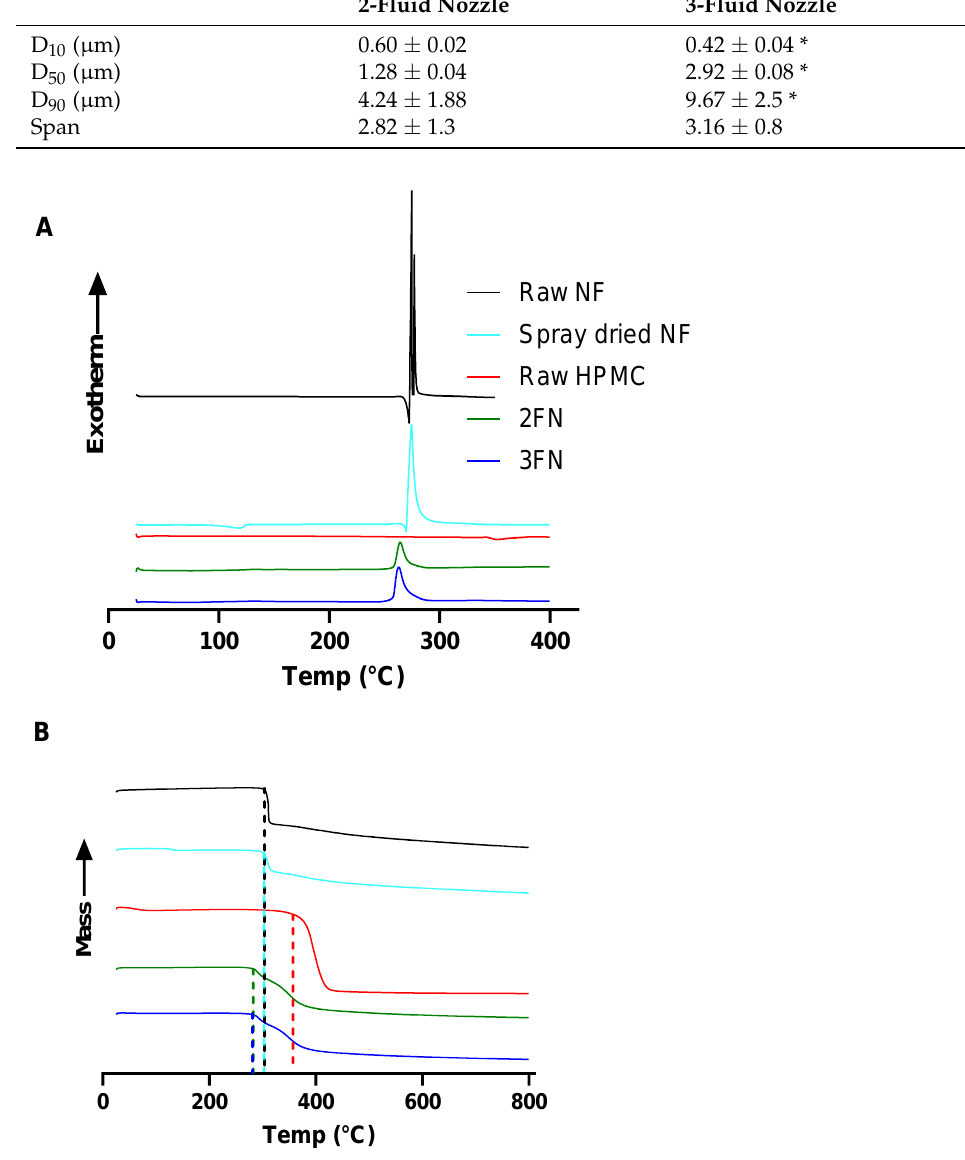
Figure 3. ( A ) Differential scanning calorimetry thermograms displaying the thermal properties of 2FN, 3FN powders, raw NF, spray dried NF and raw HPMC. ( B ) Thermogravimetric Analysis of 2FN, 3FN, raw NF, raw HPMC and spray-dried NF.